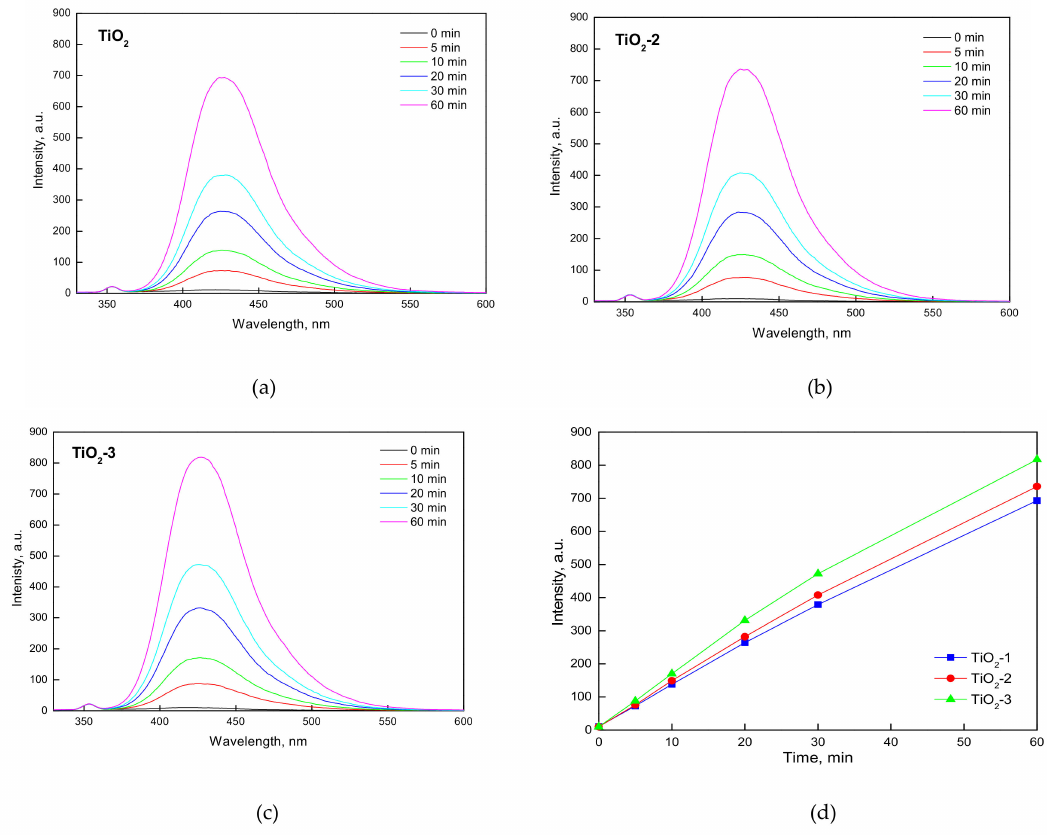
Figure 6. Fluorescence signal intensity of 2-hydroxyterephthalic acid (TAOH) vs. time over ( a ) TiO 2 -1, ( b ) TiO 2 -2, and ( c ) TiO 2 -3 after irradiation with UVA light; ( d ) intensity of fluorescence signal of TAOH over TiO 2 -1, TiO 2 -2, and TiO 2 -3 at λ = 425 nm as a function of